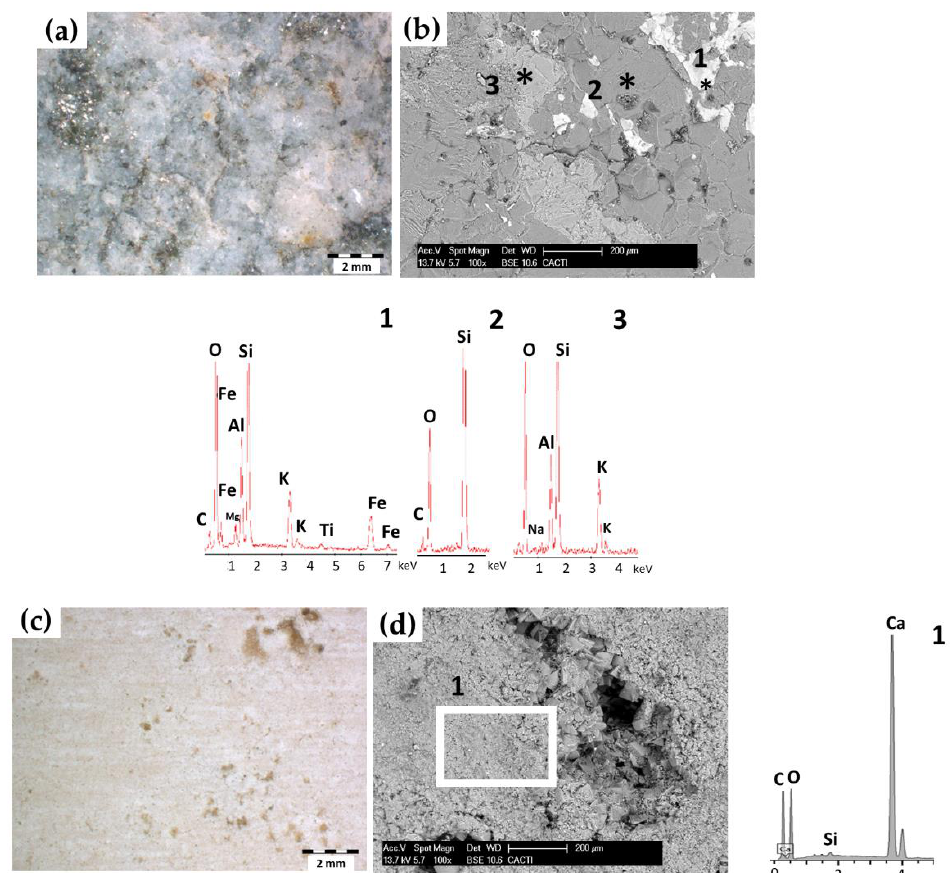
Figure 1. Micrographs taken with stereomicroscopy and scanning electron microscopy of the reference stones. ( a , b ): Gneiss. ( c , d ): Travertine. Moreover, energy–dispersive X-ray (EDX) spectra of the forming minerals are depicted.